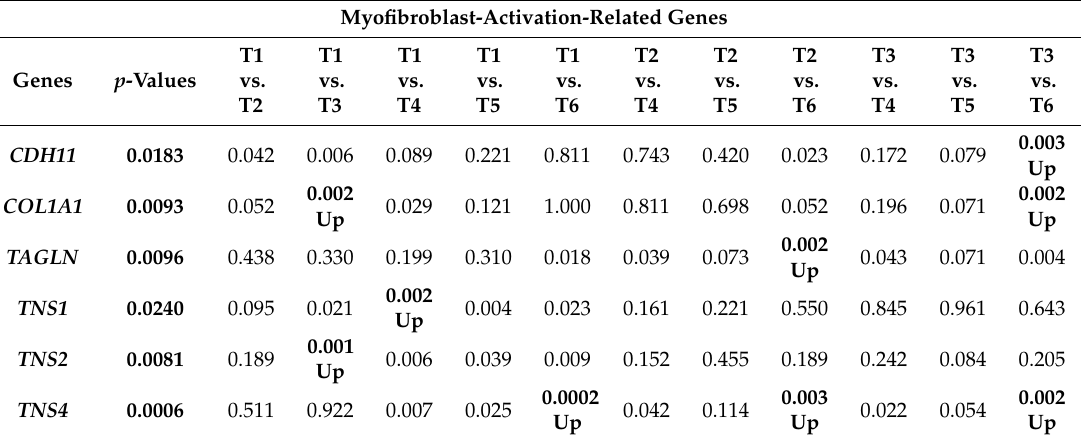
Table 2. Di ff erentially expressed genes involved in the activation of myofibroblasts.